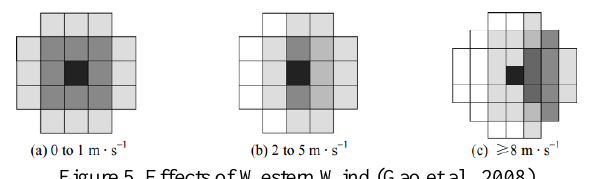
Figure 5. Effects of Western Wind (Gao et al.,